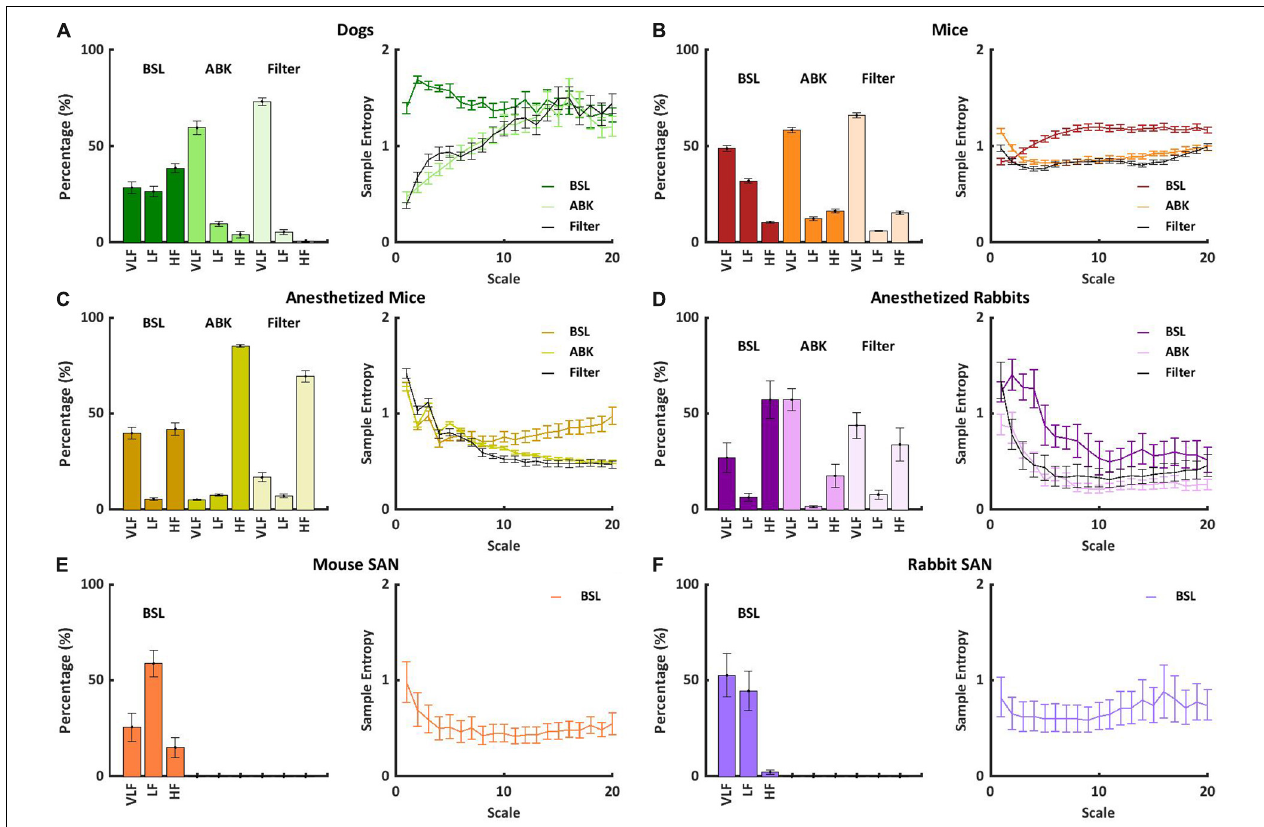
FIGURE 2 | Short- and long-range heart rate variability (HRV) under BSL and ABK states. Normalized power in the very low frequency (VLF), low frequency (LF), and high frequency (HF) bands and average multiscale entropy in (A) dogs ( n = 14, aged 1–4 years), (B) awake mice ( n = 5, aged 2–4 months), (C) anesthetized mice ( n = 6, aged 2–4 months), (D) anesthetized rabbits ( n = 8, aged 2–4 months), (E) mouse ex vivo sinoatrial nodes (SANs) ( n = 12, aged 2–4 months), and (F) rabbit ex vivo SANs ( n = 9, aged 1–4 years). Frequency and multiscale entropy dog results of BSL and ABK are from Rosenberg et al.